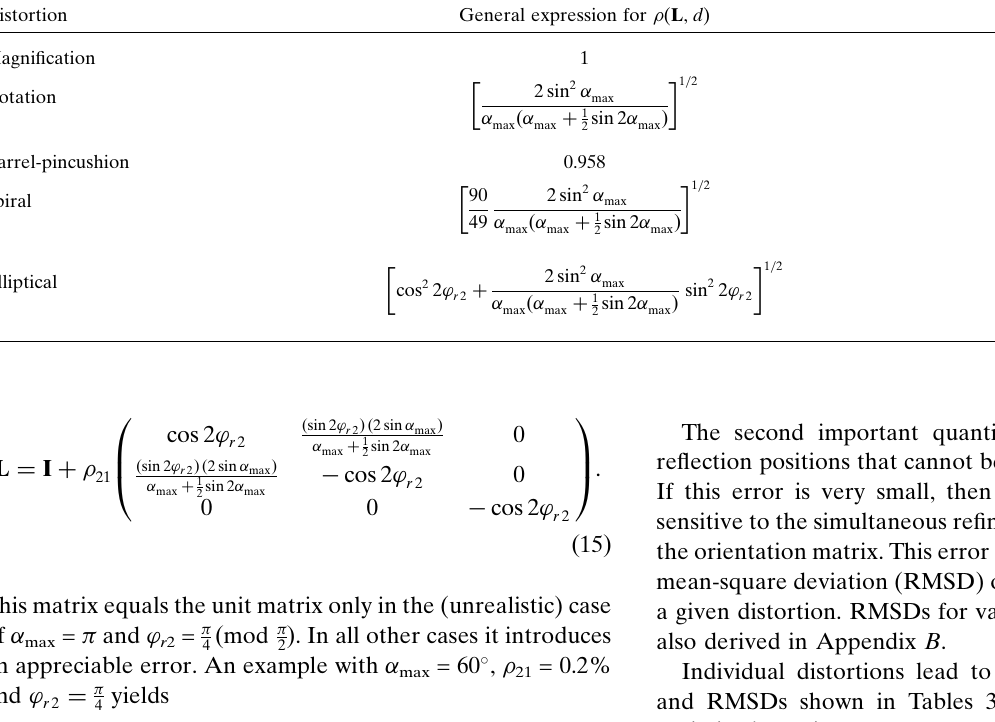
Table 3 Correlation coefficient (cid:3) ( L , d ) for individual standard distortions. Distortion General expression for (cid:3) ( L , d )